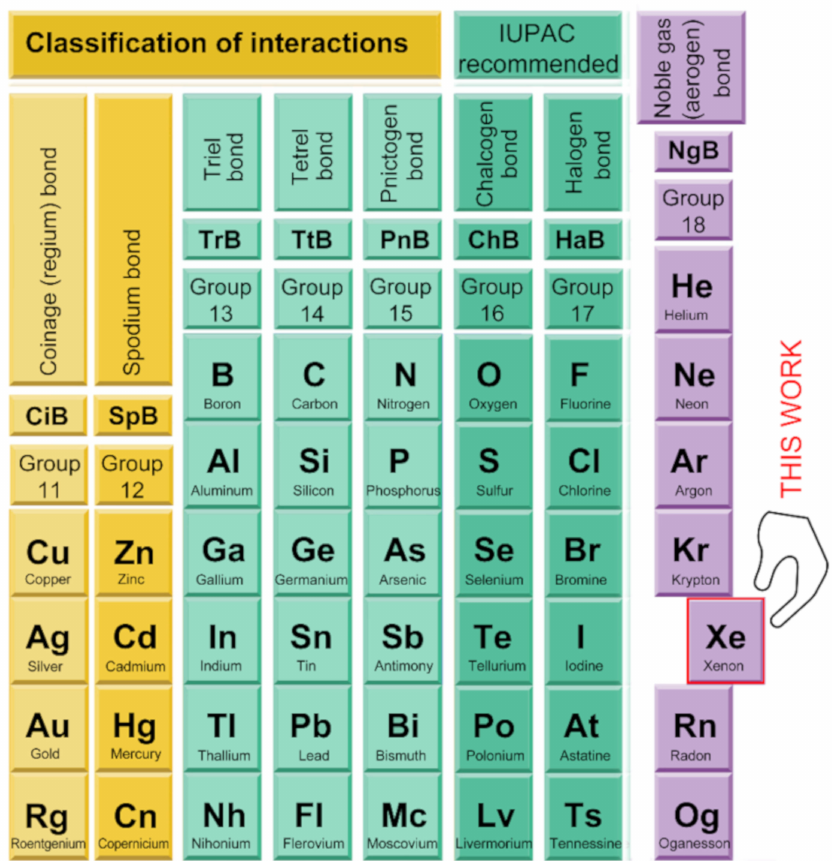
Figure 1. Groups 11 to 18 and their respective names that are used in the